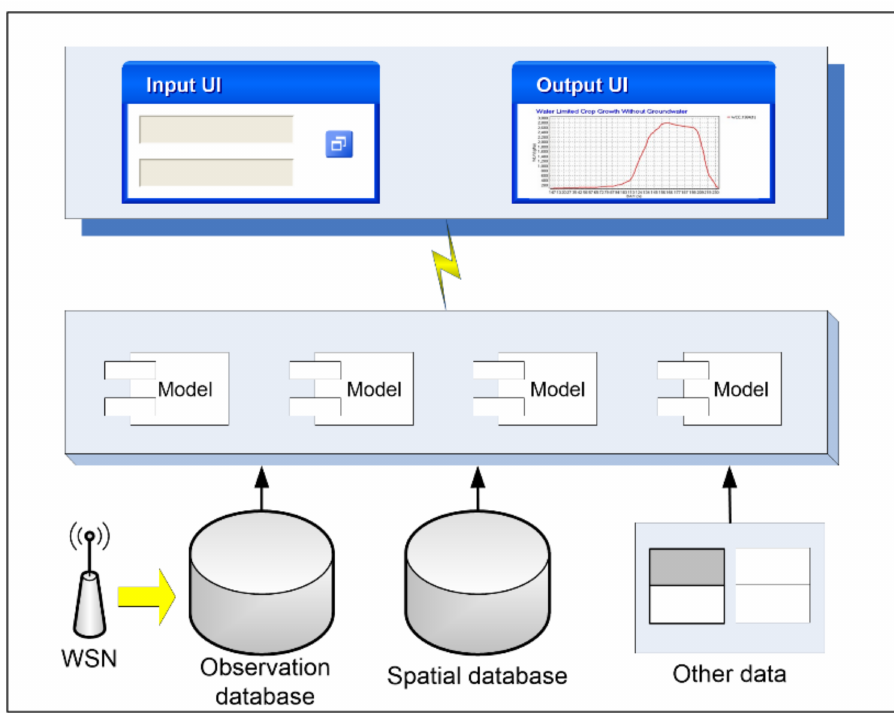
Figure 6. The logic architecture of model integration in the